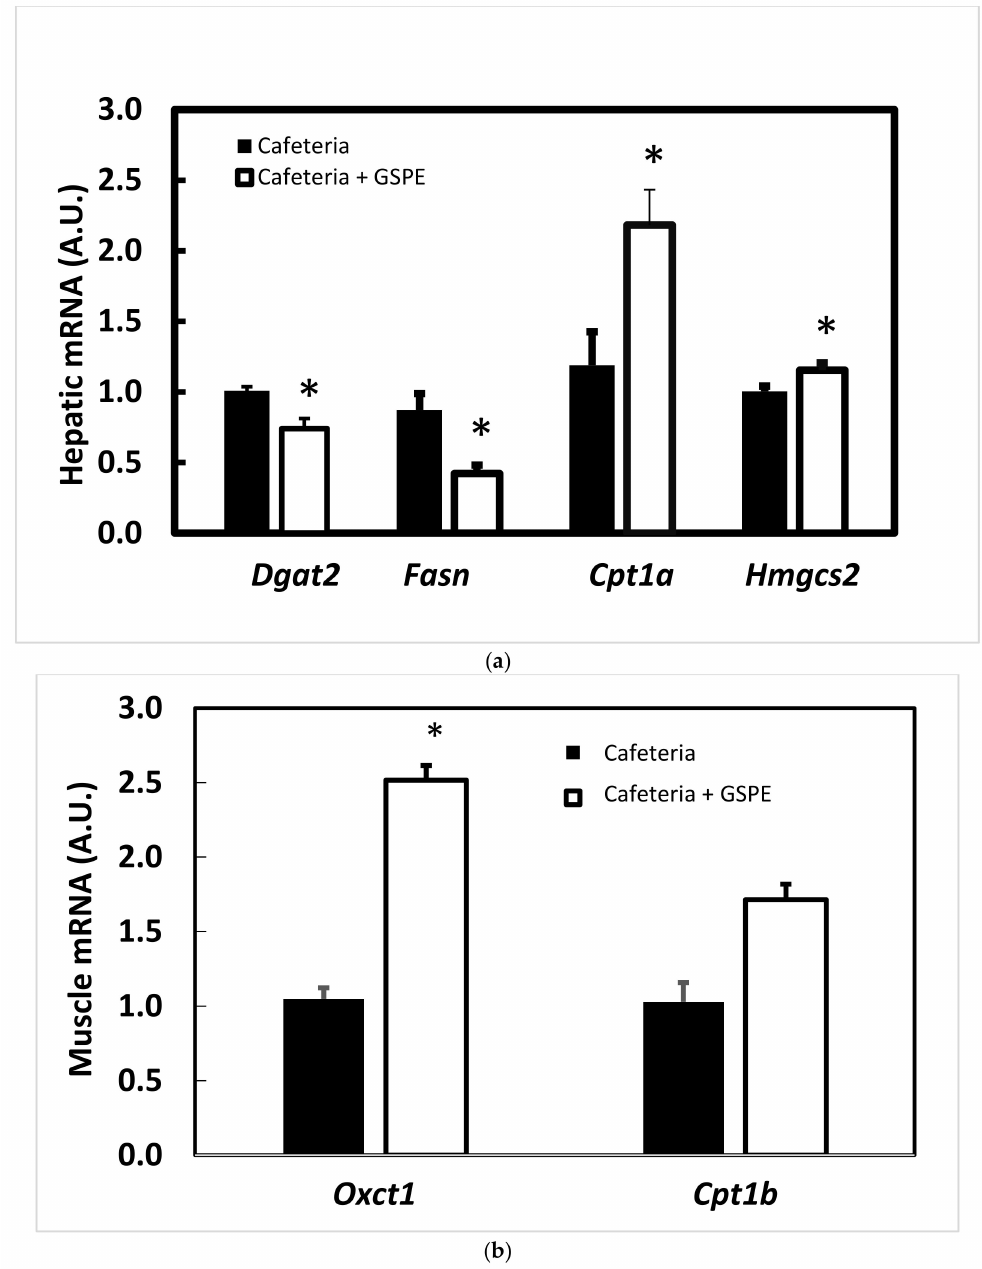
Figure 4. E ff ect of GSPE pre-treatment on gene expression in the short cafeteria study at the end of the study. Rats were treated with 0.5 g / Kg BW for the first 10 days, and then they were put on a chow diet for 18 days and a cafeteria diet for 35 days. The black column indicates animals not treated with GSPE. The white column indicates animals treated with 0.5 g / Kg BW of GSPE for the first 10 days of treatment. The mRNA extracted from liver was quantified by RT-PCR and the relative gene expression detailed gens was obtained by the DDCt method in each gene. Figure 4a resumes liver results. Figure 4b summarizes muscle gene expression. The data are the mean ± S.E.M. (n = 7). Statistical di ff erences identified by t -test are defined by * when p < 0.05 between